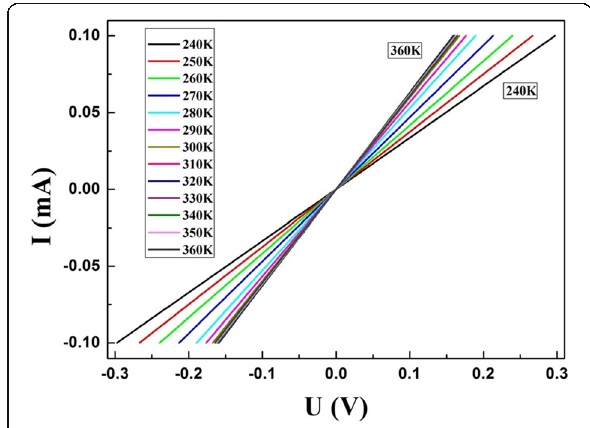
Fig. 8 I - V curves of the PANI/TPU membrane sensor under different